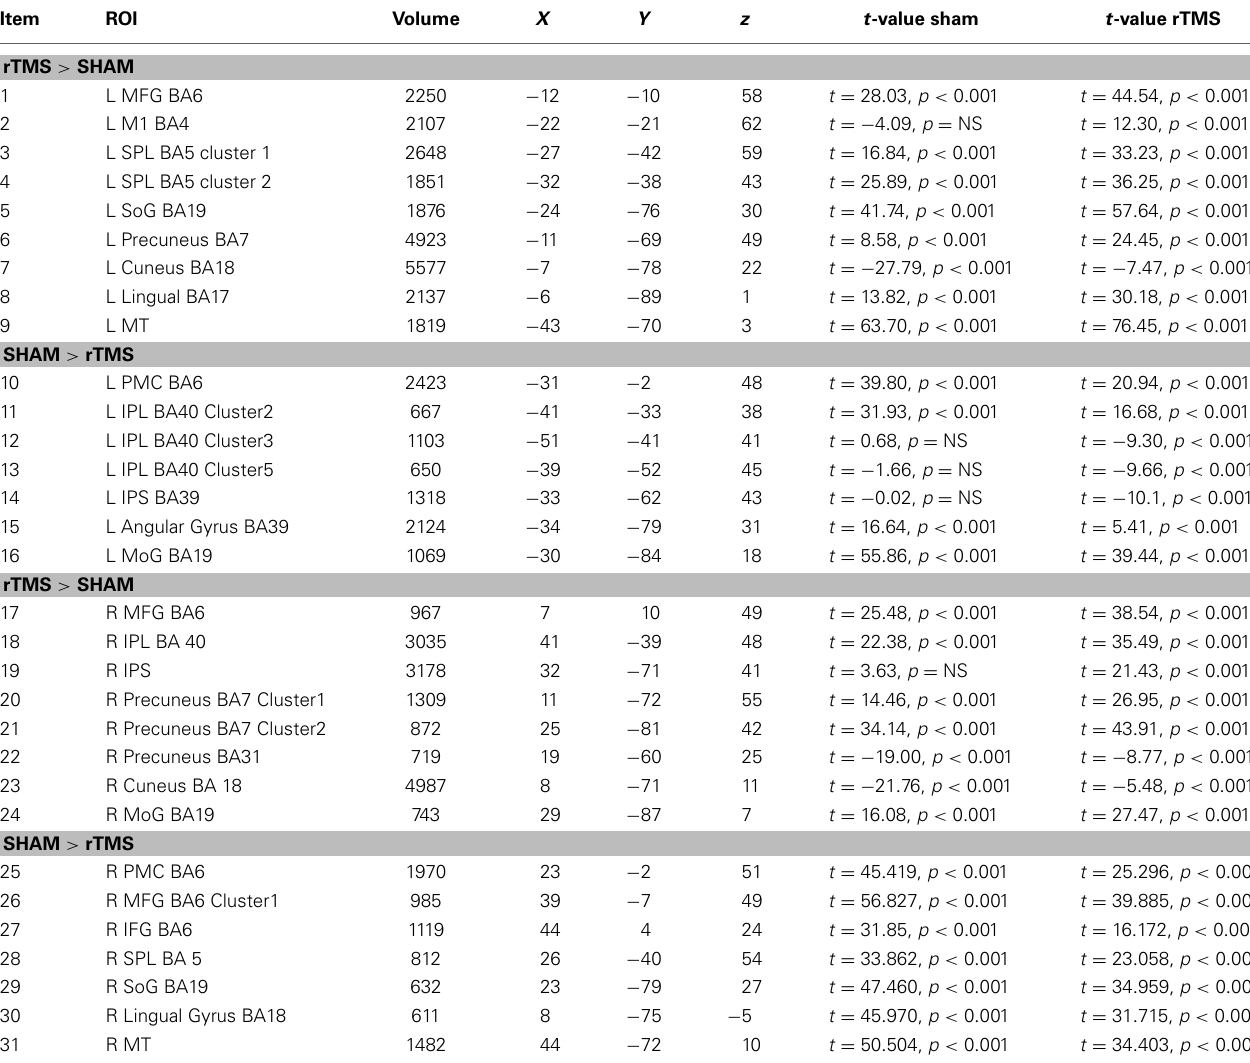
Table 1 | fMRI-Regions of interest analysis (ROIs) identified from Multi-Subject Fixed Effects GLM analysis (Figure